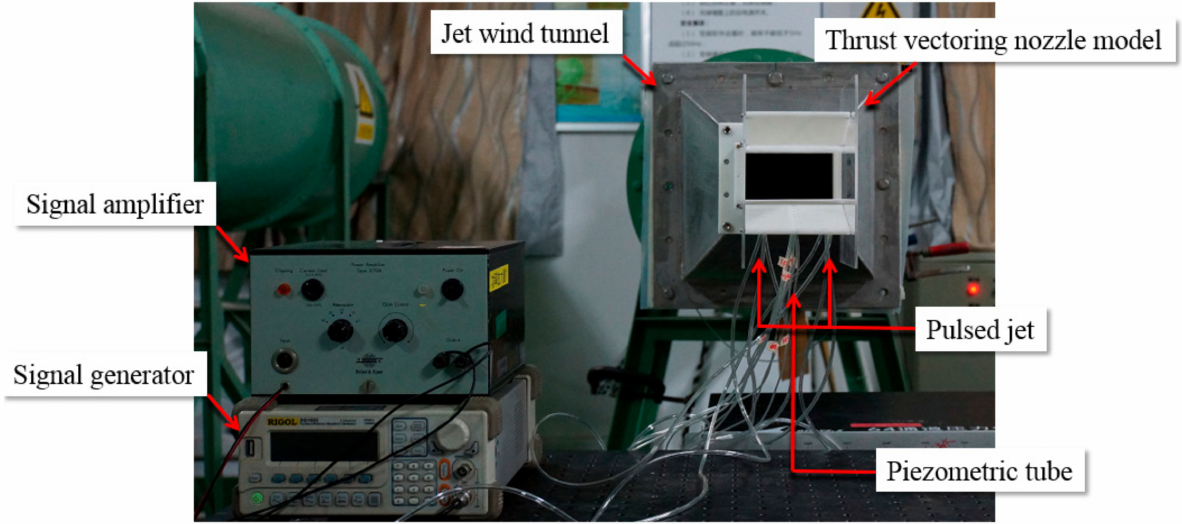
Figure 4. The layout of the dynamic pressure measurement on the active flow control experiment.